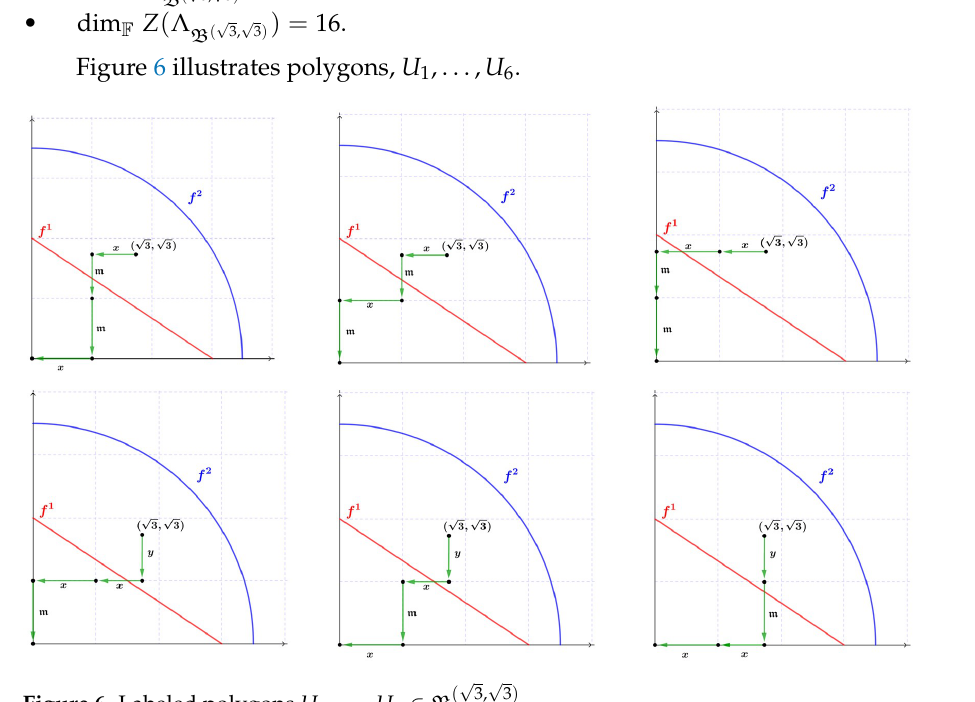
Figure 6. Labeled polygons U 1 , . . . , U 6